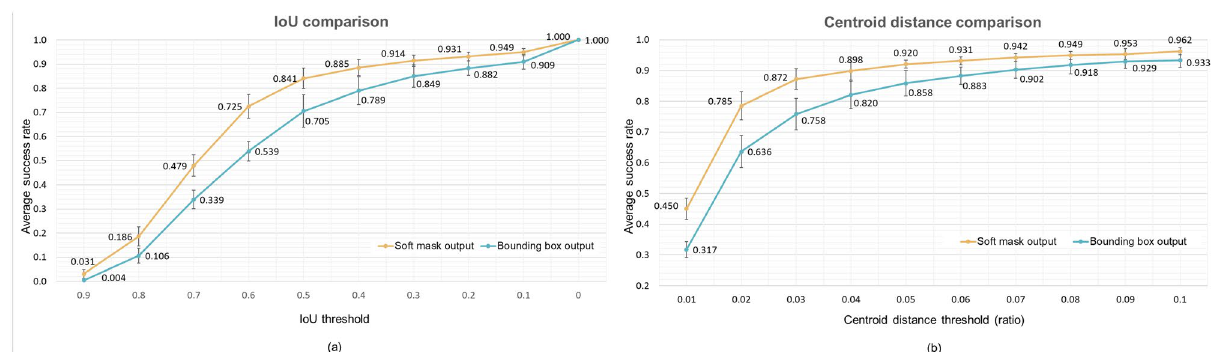
Figure 3. ( a ) The success plot with decreasing IoU threshold. The model that predicts soft masks is superior to the model that directly predicts bboxes. The former has a success rate of 91.4% for the threshold of 0.3, showing sufficient performance to assist the ERCP procedure. ( b ) The success plot with increasing centroid distance threshold. The model with soft mask output always performs better than the model with bbox output. Also, the former achieved a high success rate for the challenging threshold of